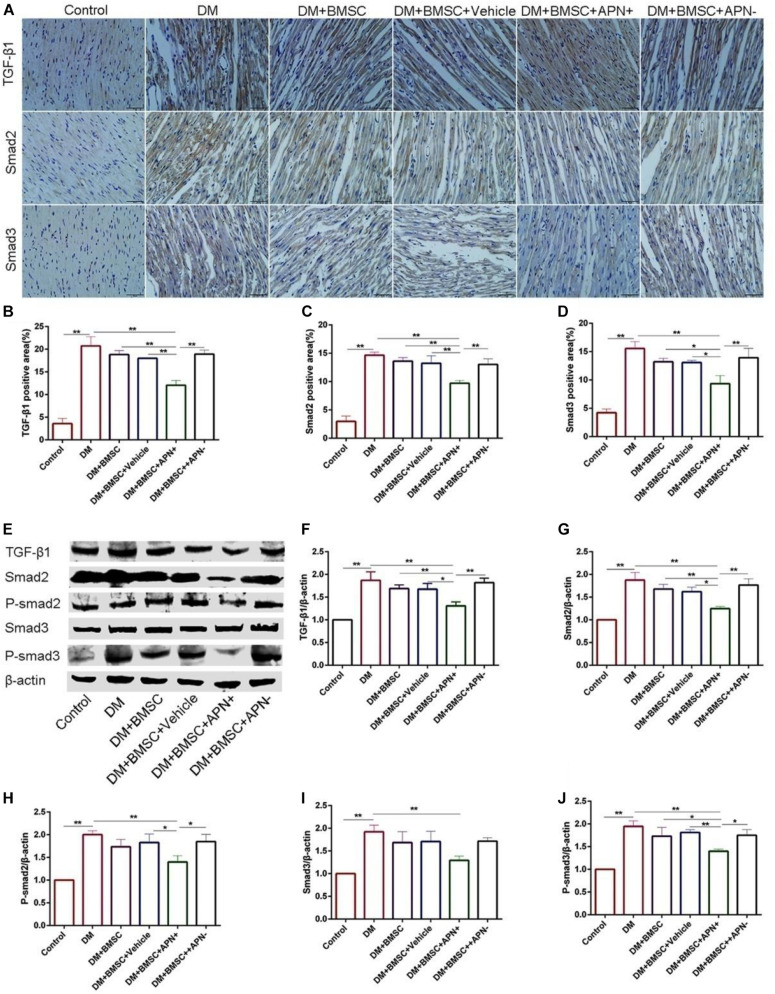
The expression of TGF-β1/Smad 2,3 in all groups rats. (A) Immunostaining of TGF-β1, Smad2 and Smad3. (B) Quantitative analysis of TGF-β1. (C) Quantitative analysis of Smad2. (D) Quantitative analysis of Smad3. (E) Representative western blot: TGF-β1, Smad2, P-smad2, Smad3, and P-smad3. (F) The western blot assay of TGF-β1. (G) The western blot assay of Smad2. (H) The western blot assay of P-smad2. (I) The western blot assay of Smad3. (J) The western blot assay of P-smad3. Data are mean ± SD; *p < 0.05, **p < 0.01.